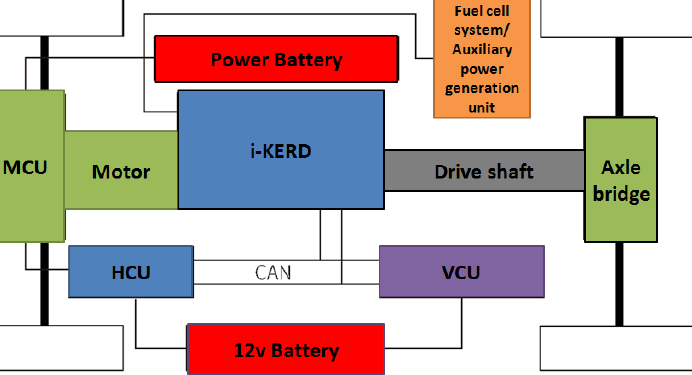
Figure 7. System configuration of fuel cell/range-extended EV with i-KERD.